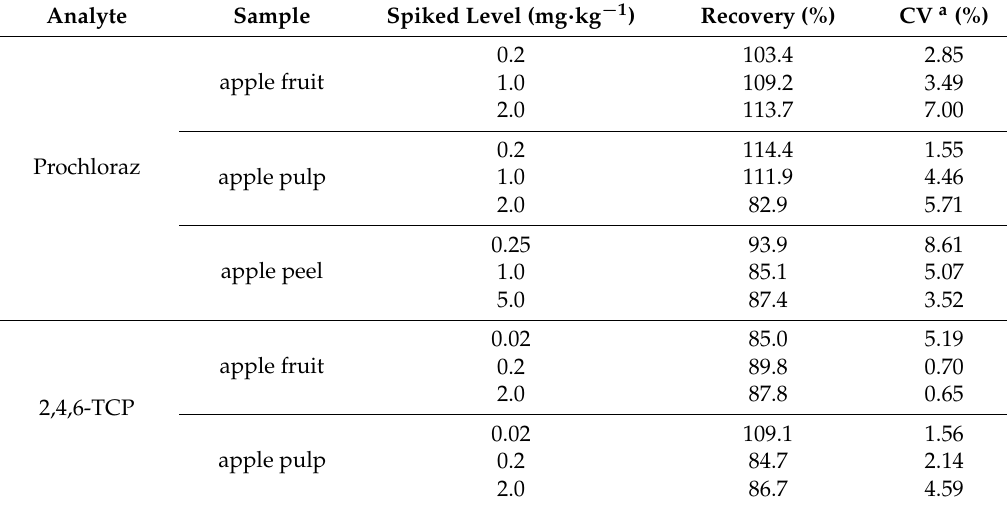
Table 2. Recovery studies of samples spiked with prochloraz and 2,4,6-TCP by GC-ECD.